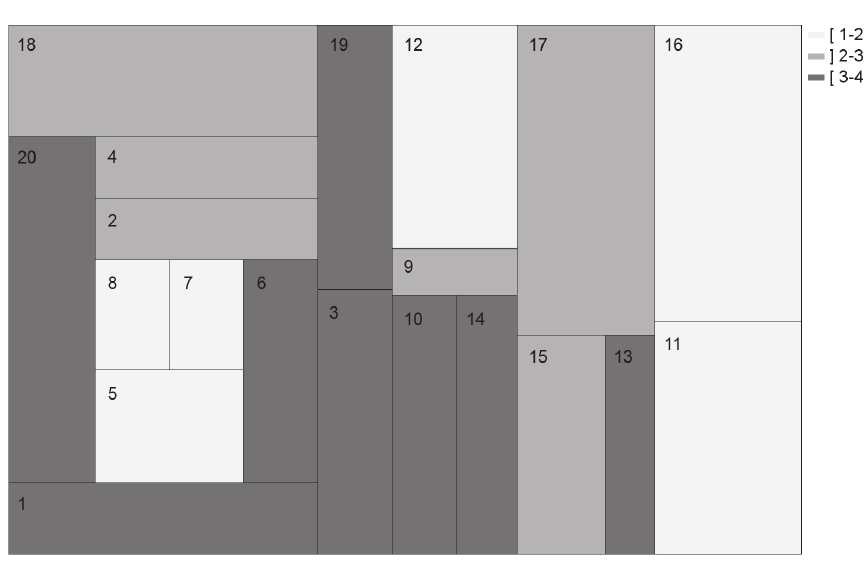
Fig. 4. Best layout obtained by Kang and Chae (2017)